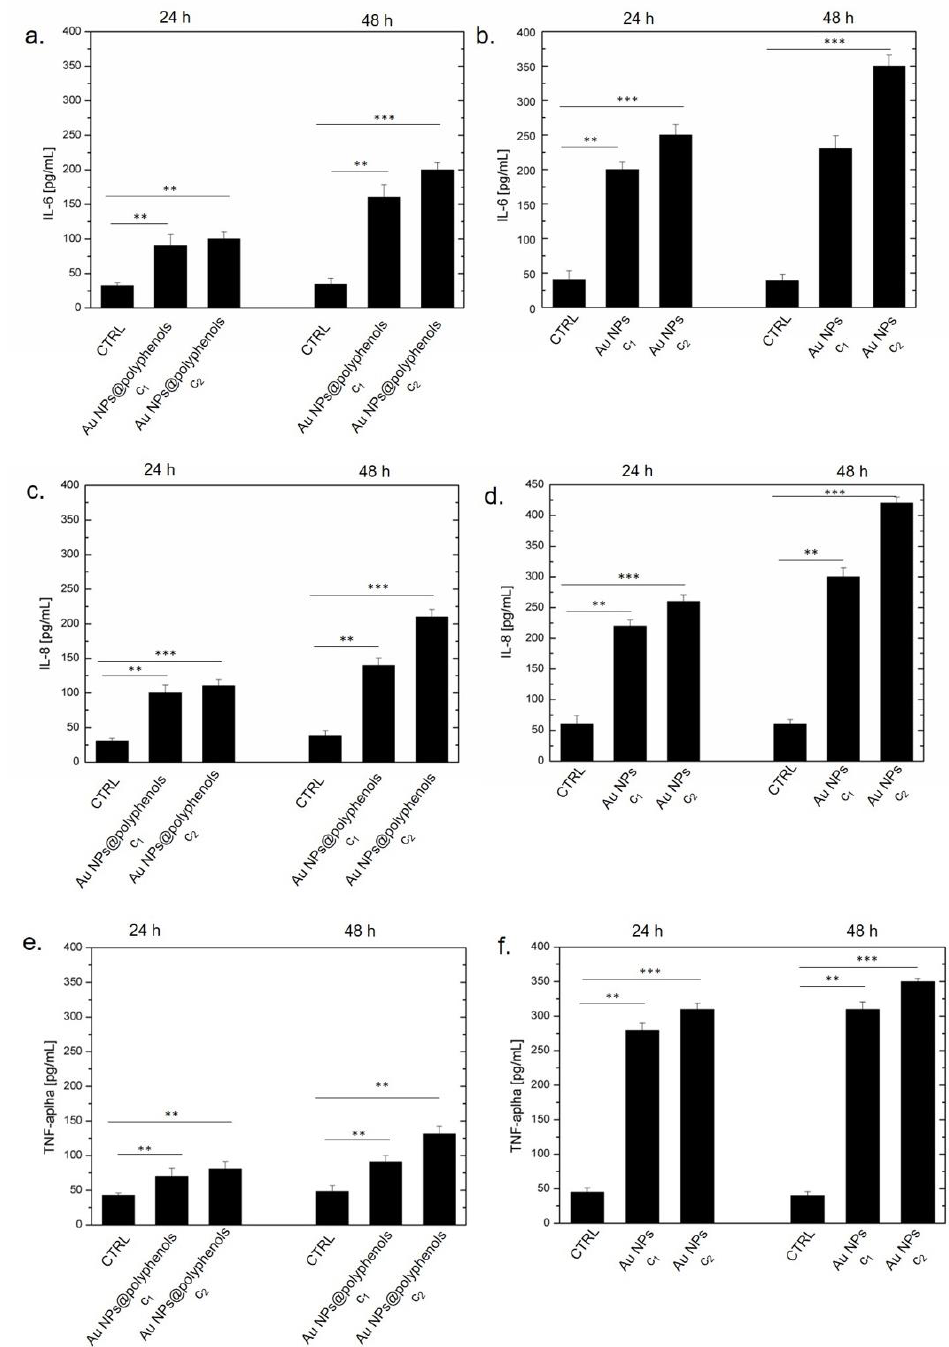
Figure 5. Levels of IL-6 ( a , b ), IL-8 ( c , d ), and TNF-α ( e , f ), expressed as pg/mL. The assessment was conducted by incubating cells with Au NPs@polyphenols and conventional Au NPs at two concentrations (c1 and c2) for 24 h and 48 h. The cytokine levels were detected in supernatants from the control cells and the treated cells by an ELISA assay. The results are expressed as the mean ± standard deviation of three separate experiments. ** p < 0.01, *** p < 0.001 respect to the control of each time point.